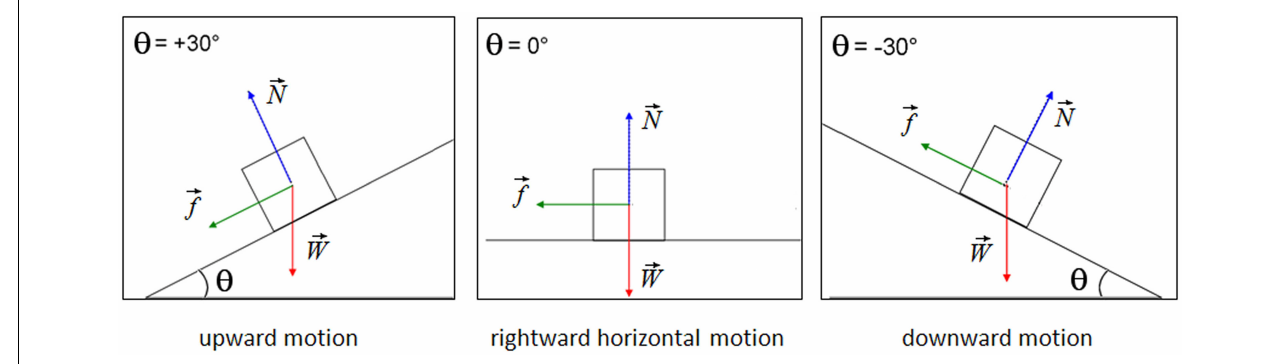
FIGURE 3 | Illustration of the forces concomitant to a rightward motion.